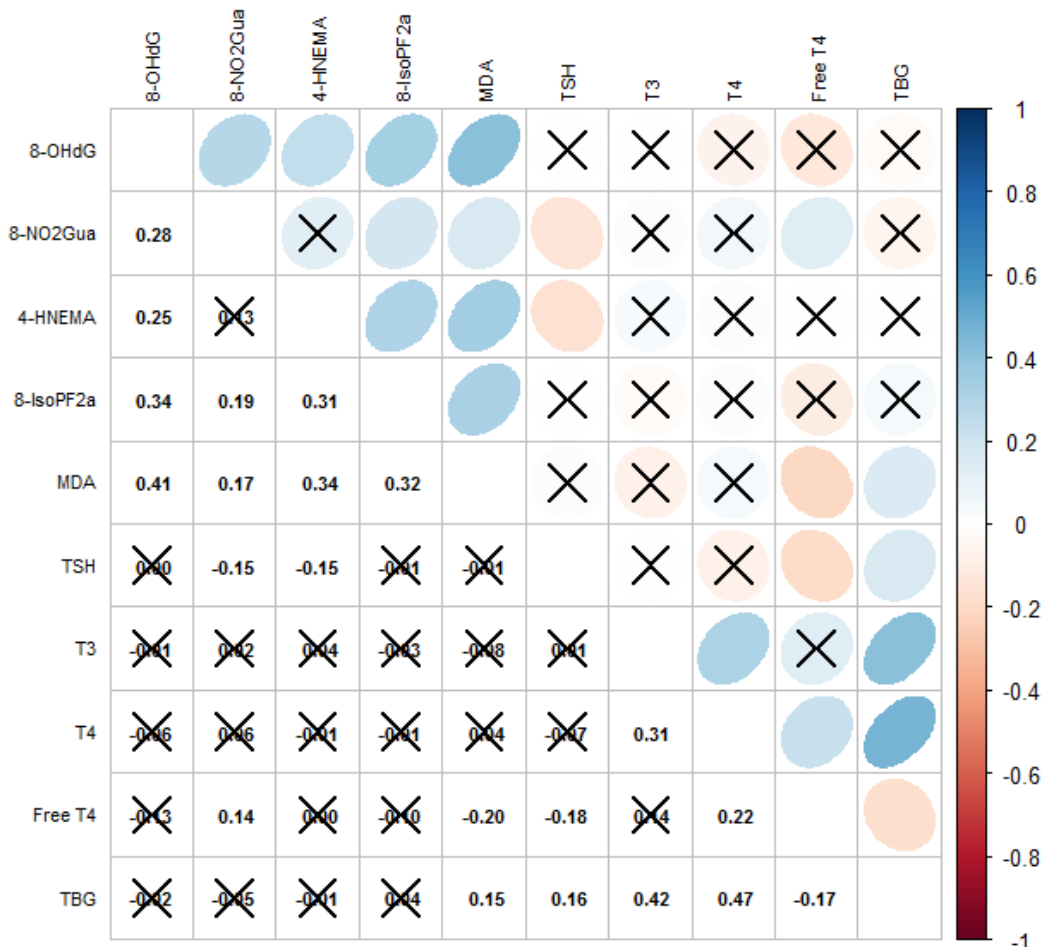
Figure 1. Correlations among oxidative/nitrosative stress biomarkers and thyroid hormones. Cross mark means correlation is not significant ( p -value ≥ 0.05); blue means positively correlated; red means negatively correlated.